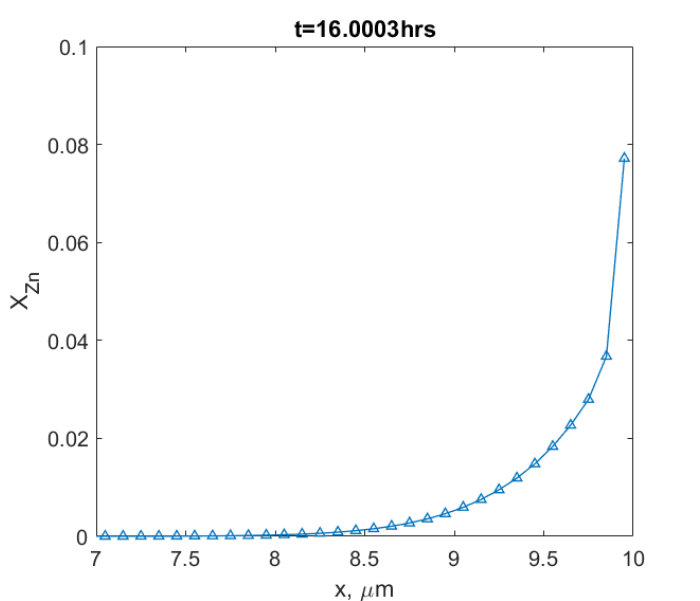
Figure 4. X Zn profile at the surface left behind by the moving grain